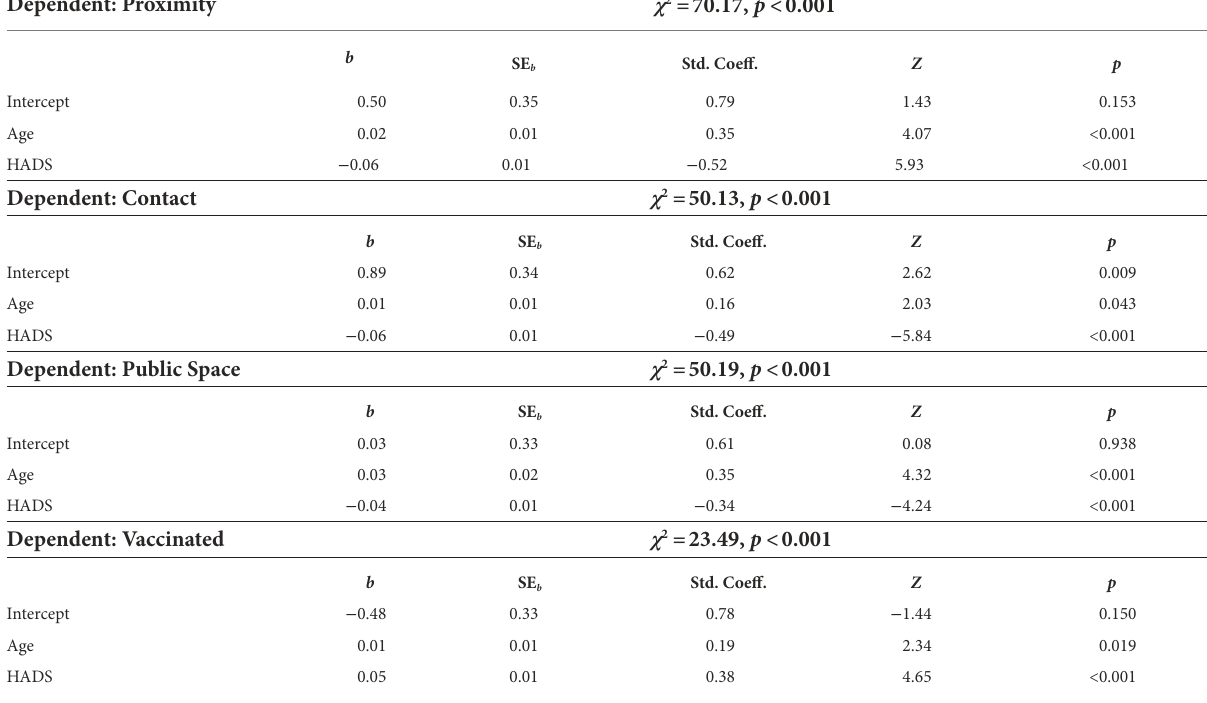
TABLE 3 Logistic regression analyses of the contributions of age and distress to social distancing and vaccination. Dependent: Proximity